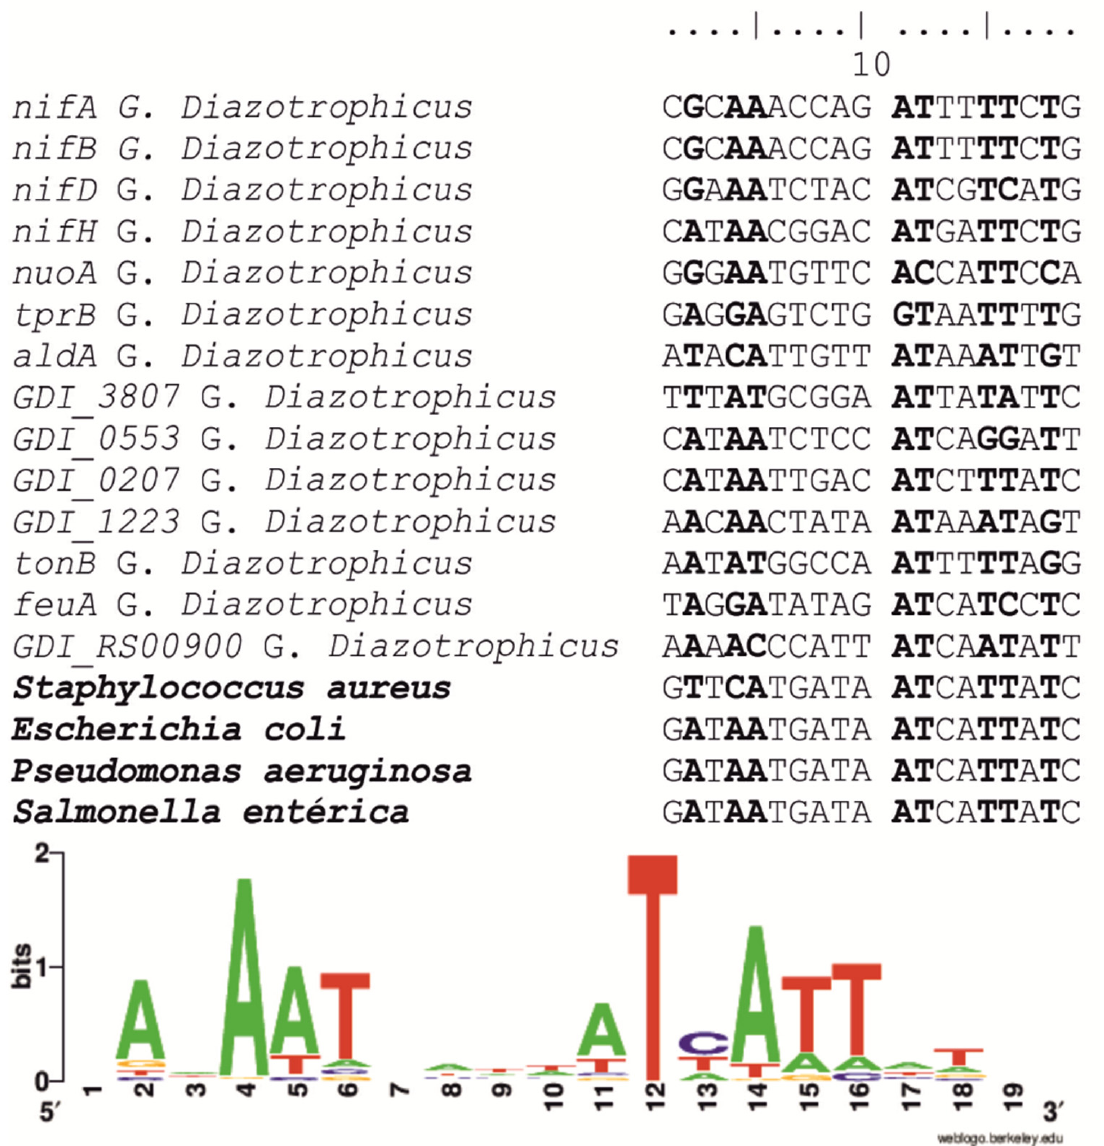
Figure 5. DNA sequence representing G. diazotrophicus fur -binding site. (Upper). Pairwise alignment of the derived fur box consensus sequences of S. aureus , E. coli , P. aeruginosa S. enterica and G. diazotrophicus . (Lower). Sequence logo of the fur box of G. diazotrophicus derived from bioinformatics and RNA-seq analyses. Base frequencies at each position were determined using WebLogo.